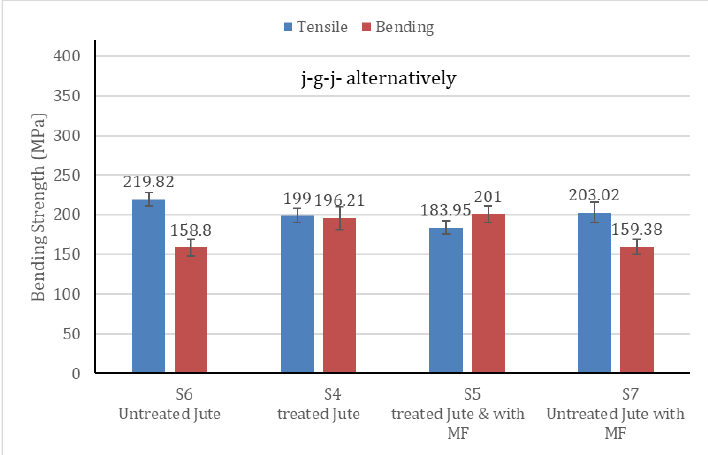
Figure 11: Average tensile and bending strength comparisons of fabricated hybrid composite panels having 4g-9j-4g stacking sequence.